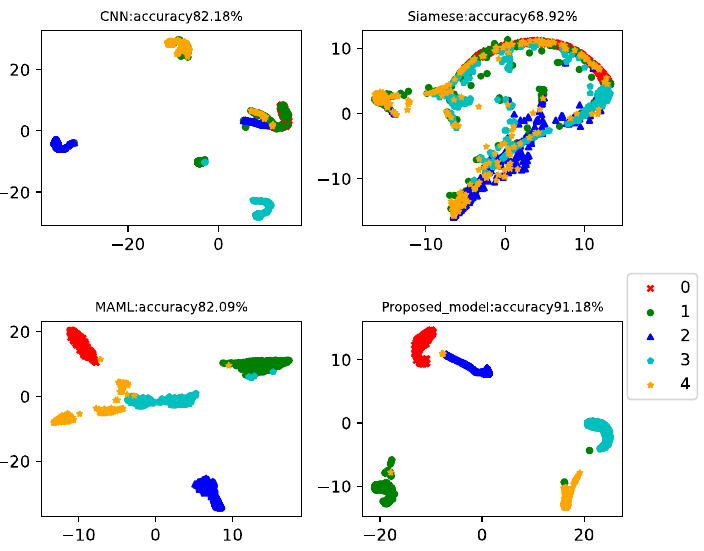
Figure 13. Five-way-ten-shot diagnosis of the wind turbine gearboxes using different algorithms.